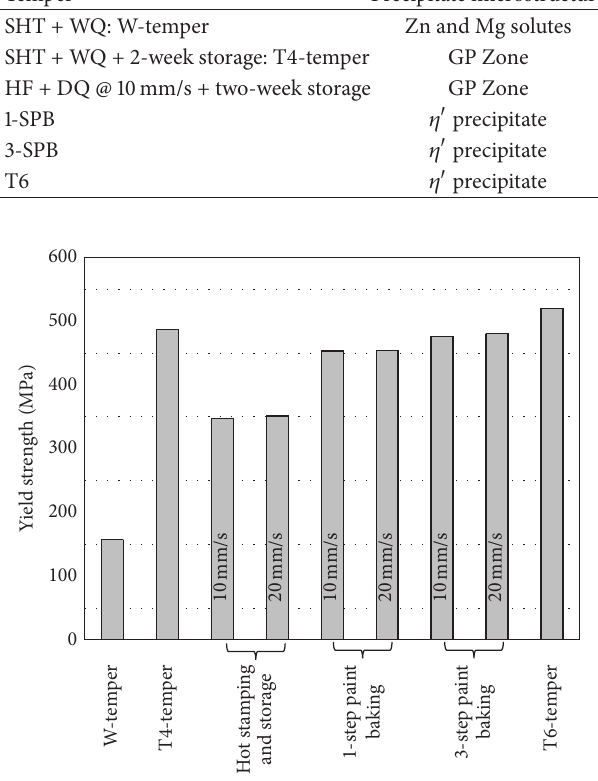
Figure 7: Effect of process steps on the yield strength of AW-7921 sheet in the warm forming process chain. The speeds shown are the rates for hot forming. All measurements made at RT except for the preheat treatment measurements. These were measured at 230 ∘